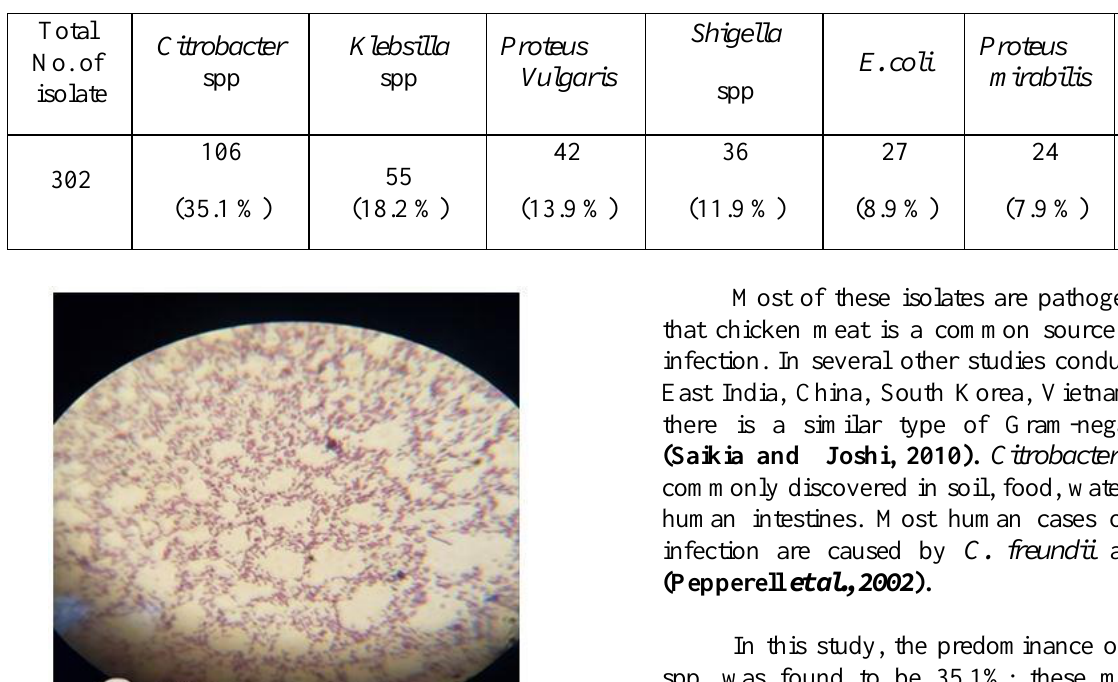
Table 2. Bacterial species were isolated from 140 samples: